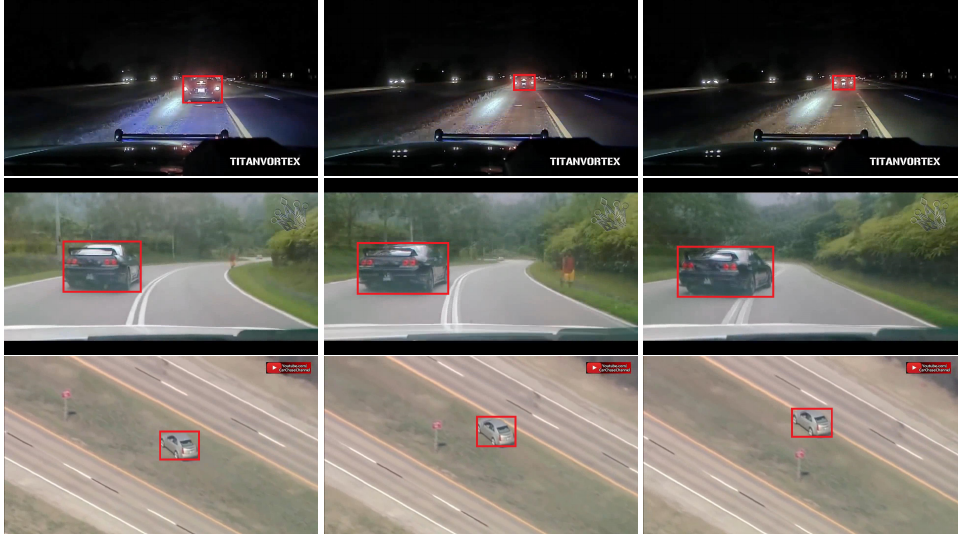
Figure 1. Visualization examples of targets of similar classes and close sizes, which are selected from car-1 , car-6 , and car-20 on the training set of LaSOT. Table 1. The mean similarity (mSim) and variance similarity (vSim) between the modulation vector of car-1 the size of 200 × 125 and those of other target objects from the LaSOT